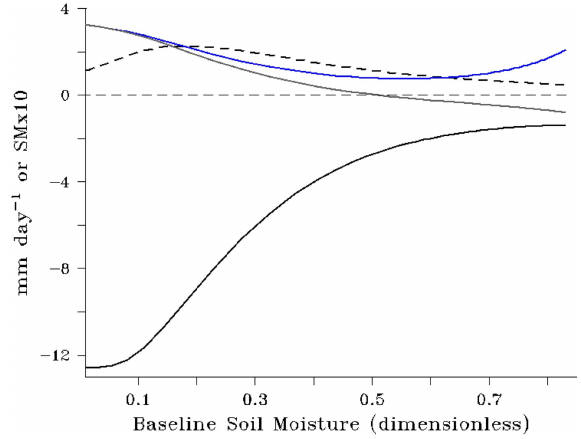
Figure 7. Differences in E p (black), E (gray), and P (blue) for a + 2K warming relative to the baseline configuration as functions of soil moisture in the baseline configuration. Also shown is the difference in soil moisture (dashed black), which has been rescaled by a factor of 10.